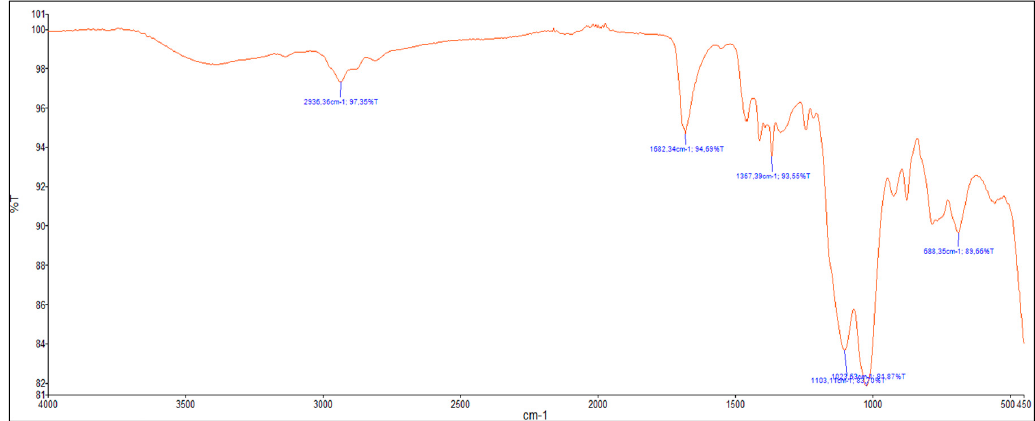
Figure 8. N 2 adsorption–desorption experiments (BET) of P3 PMONPs . Molecules 2020 , 25 , 974